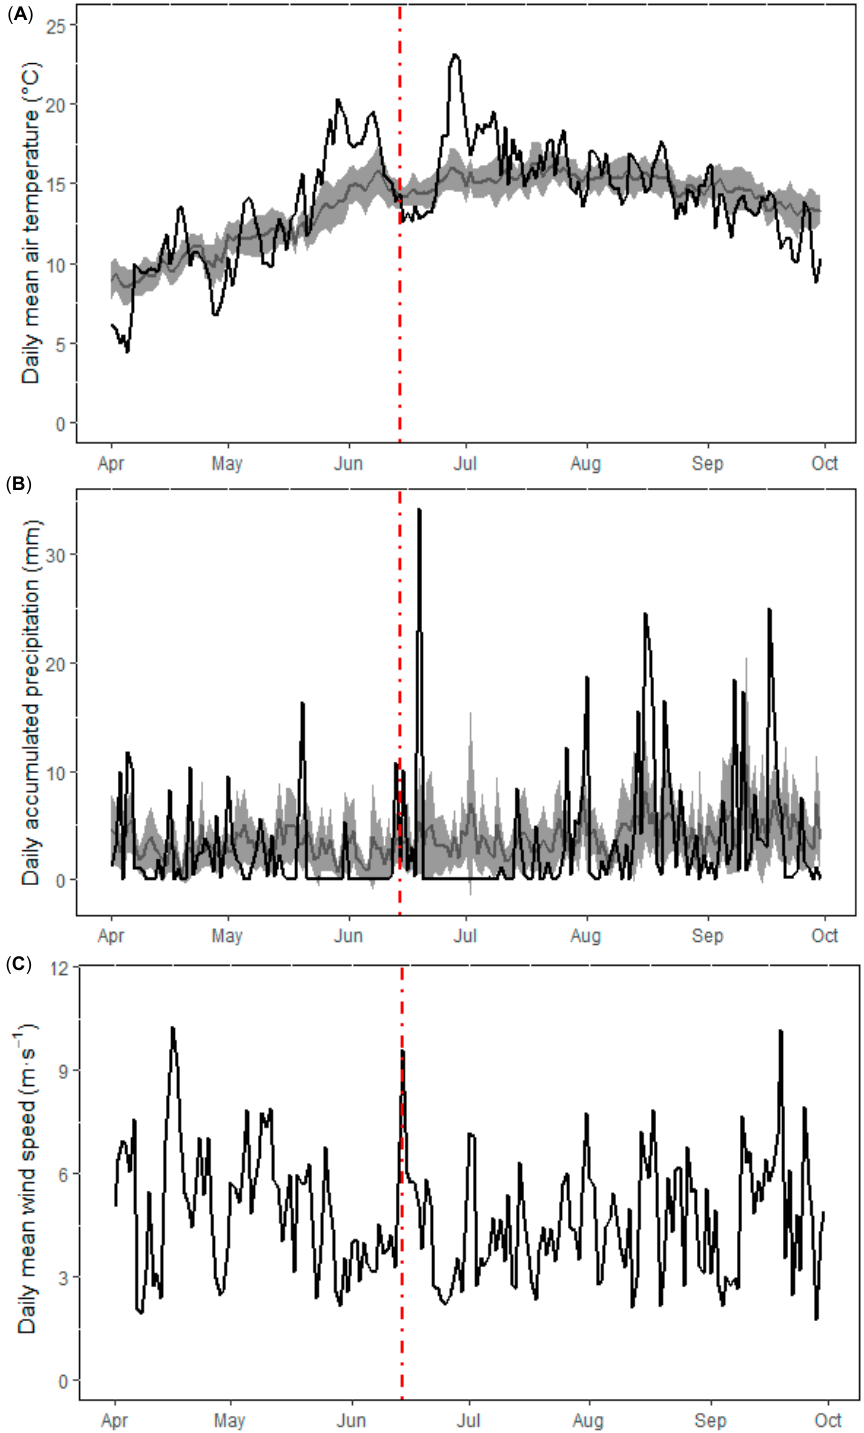
Figure 2. ( A ) Daily mean air temperature (°C) and ( B ) daily accumulated precipitation (mm) in Newport Furnace weather station. Black lines indicate 2018, the average for all years from 2004 to 2018 is shown with a grey line, and the grey shaded area indicates the 95% confidence interval around that average. ( C ) Daily 2018 mean wind speed (m · s − 1 ) recorded at Feeagh AWQMS, 2.3 m above lake surface level. The red dotted vertical lines mark the 14th June 2018 (Storm Hector).